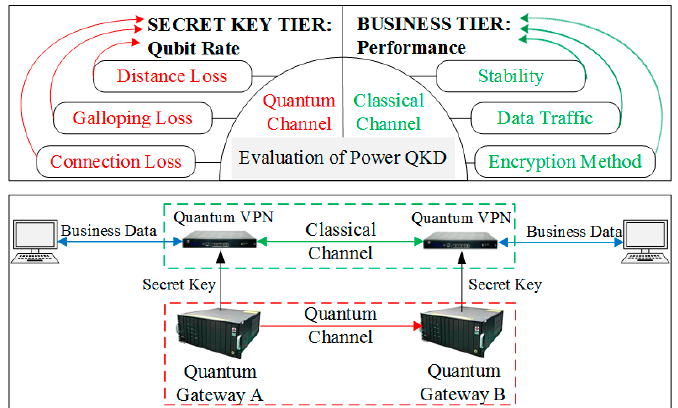
Figure 2. Evaluation indicators of power QKD system. Table 2. Wind scale and wind speed